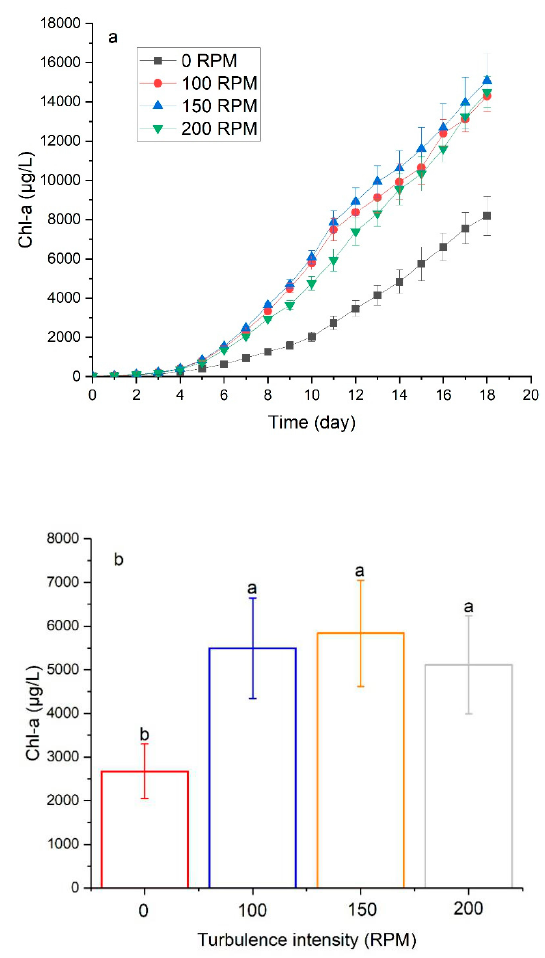
Figure 4. Chl-a concentration of Microcystis aeruginosa ( a ) and its value ranges ( b ) over the span of 18 days of incubation under different turbulence conditions. Error bars represent the SD of triplicate samples. Some error bars are too small to show. Different letters indicate significance between different treatments ( p < 0.05).